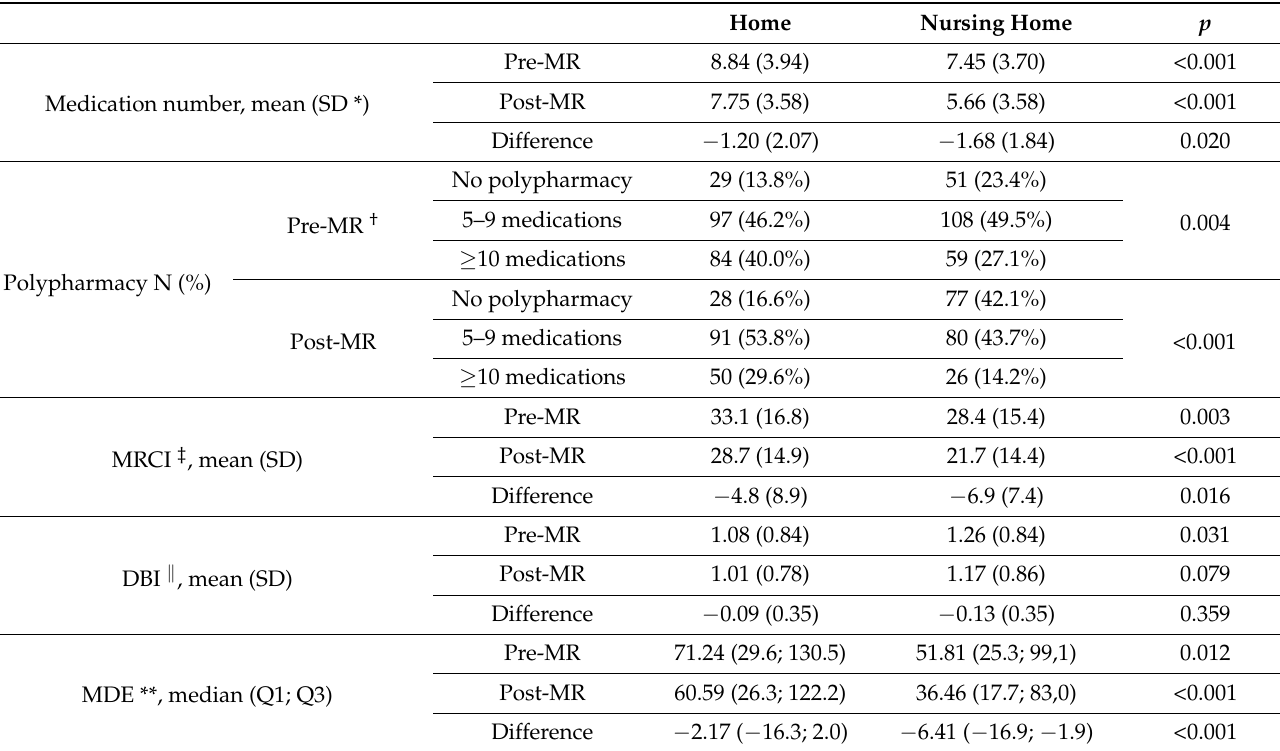
Table 4. Pre-post medication review analysis according to their place of residence, of medication number, medication regimen complexity index (MRCI), anticholinergic and or sedative burden (DBI) and monthly drug expenditure